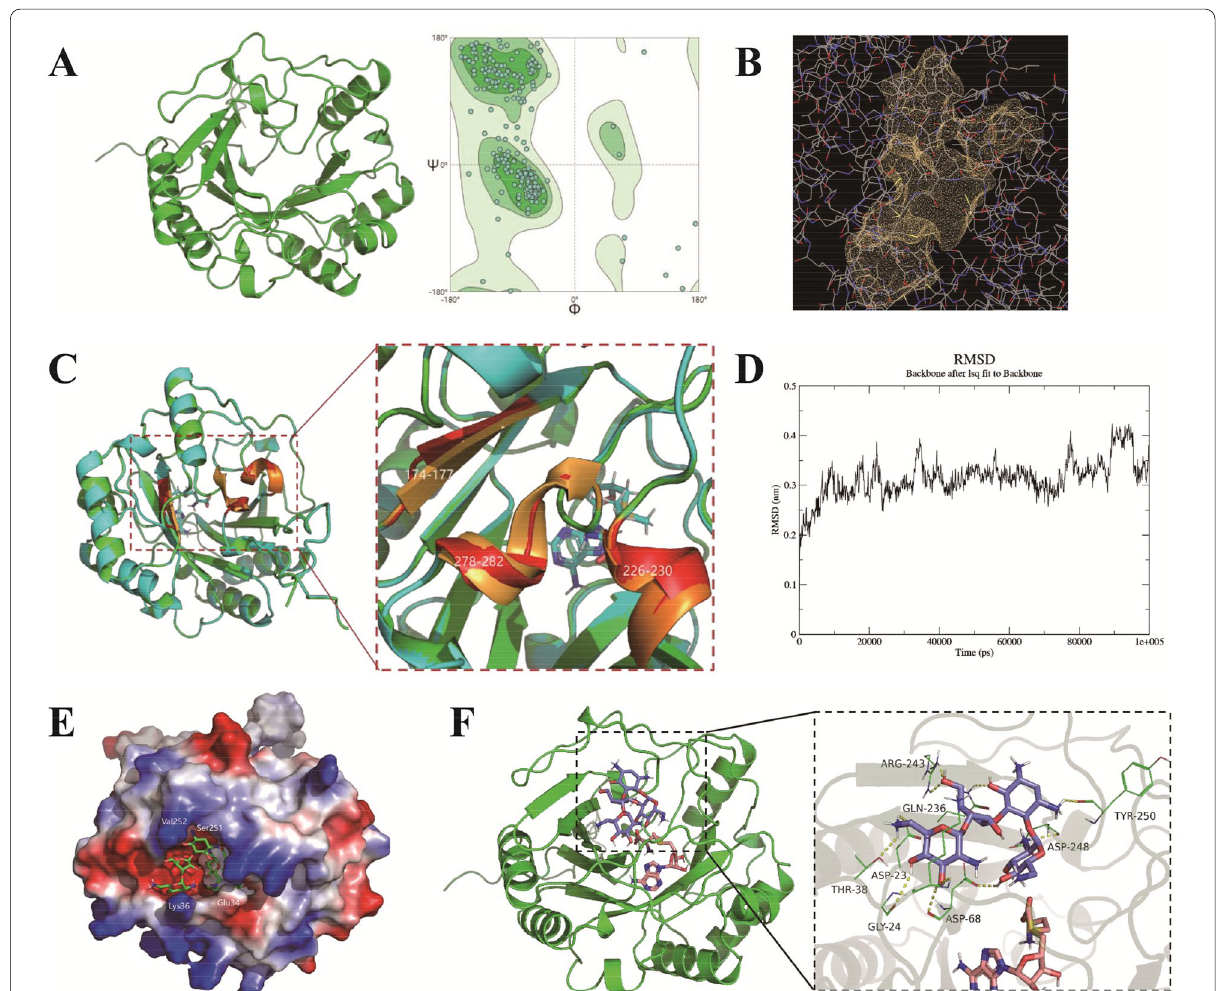
Fig. 4 Catalytic mechanism of NeoN. A Tertiary structure of NeoN. B Catalytic pockets of NeoN computed by DoGSiteScorer. C Comparison of the structure of NeoN with that of NeoN–SAM complex. D RMSD of the NeoN–SAM backbone. E Surface electrostatic potential energy of NeoN–SAM– neomycin C complex. F Docking of NeoN–SAM with neomycin